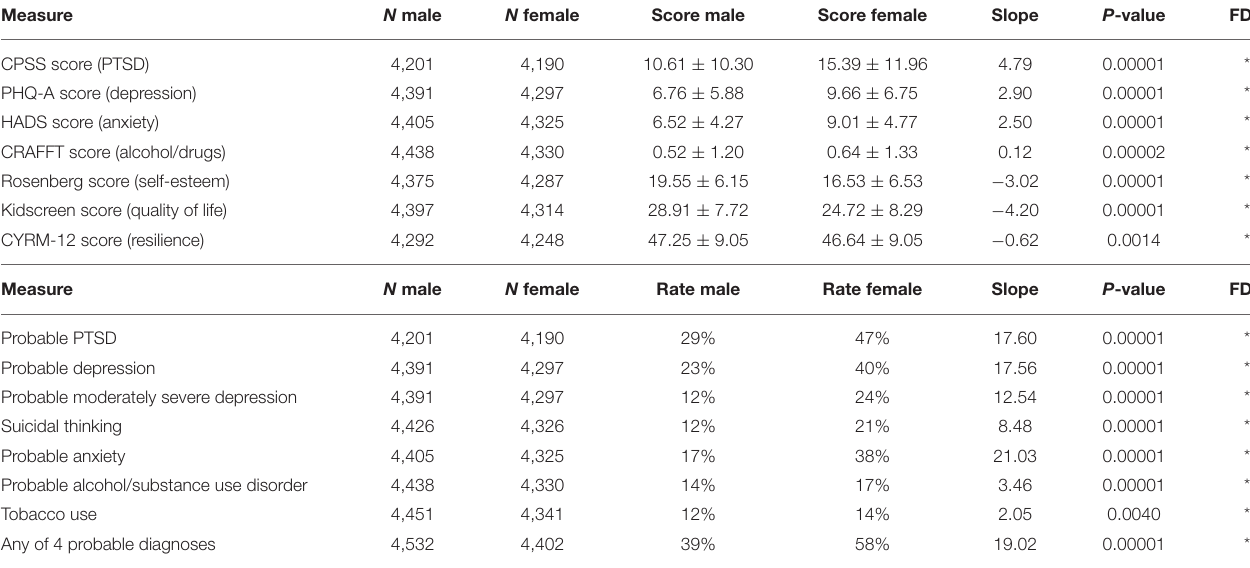
Table shows participant numbers, summary statistics, and results of analysis of effects of female vs. male gender identity. N X columns indicate number of participants identifying as gender X (female or male). Score X columns show mean ± standard deviation (not standard error) for gender X. Rate X columns indicate rates of probable diagnosis for gender X. Slope